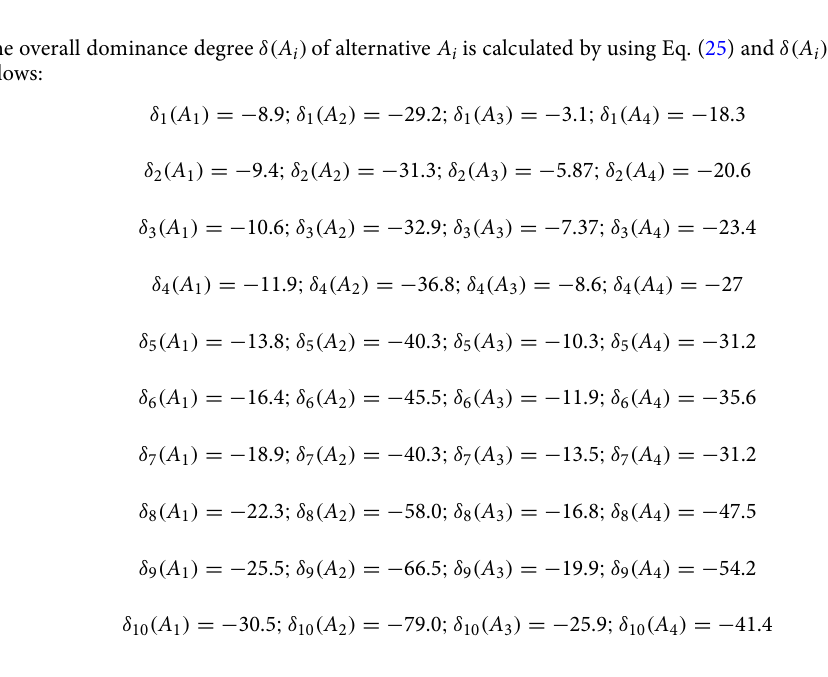
Figure 6. The objective weights relative to the reference